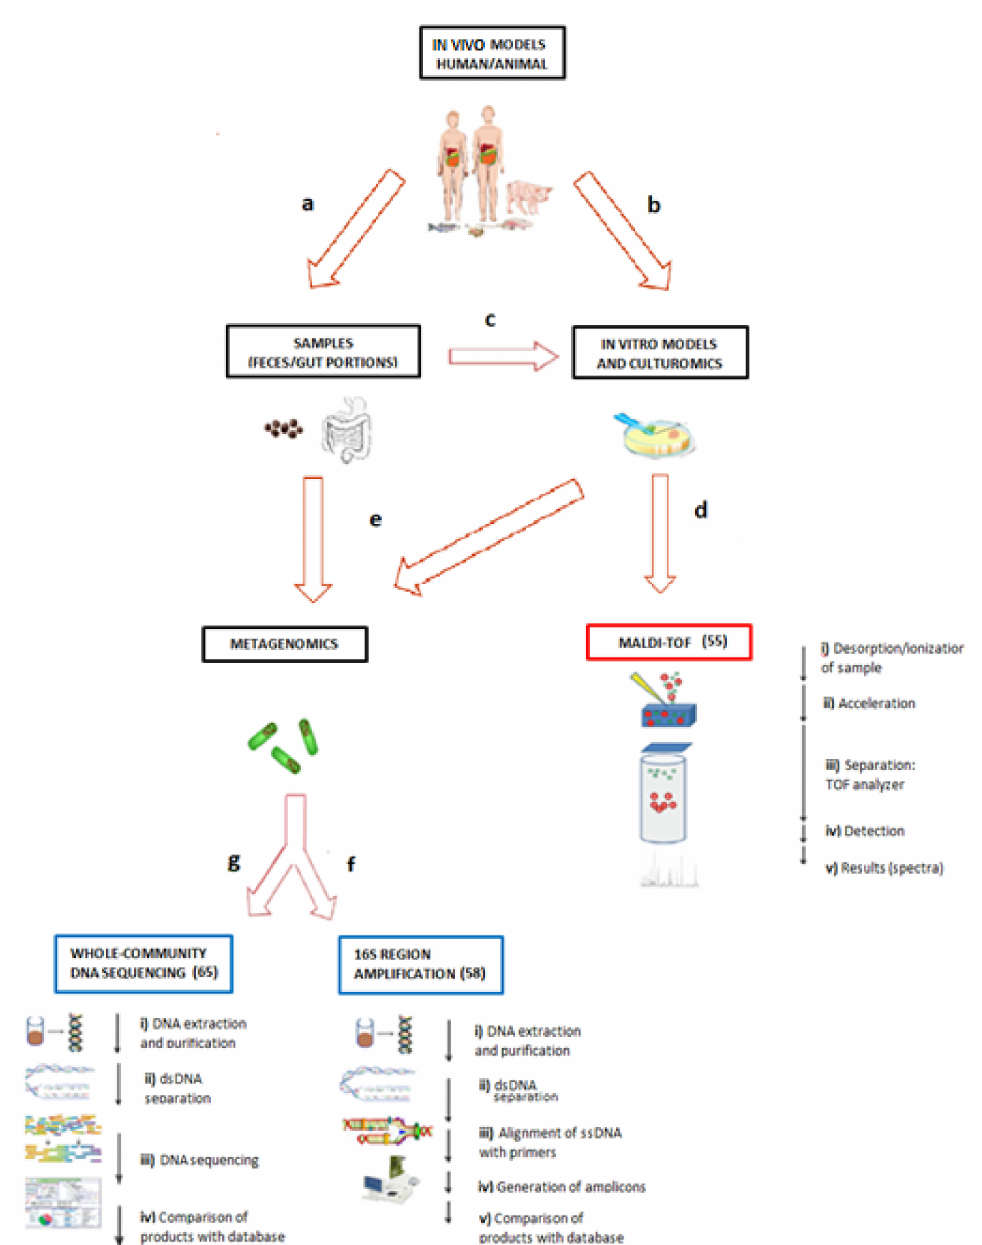
Figure 1. Primary possibilities for microbiota research. To understand the roles and interactions of the microbiota, we can start from the animal sources for ( a ) the development of an in vivo model and to obtain samples such as feces or microbiota from the gut, and ( b ) to obtain gut regions and to develop in vitro continuous organ cultures that mimic the biological environment. Likewise, once the samples from the animal models are obtained, ( c ) culturomics can be used as a powerful approach to identify the uncultured members of the gut, search for differences between species at more than the phylum level, and generate results more quickly by coupling tools such as ( d ) matrix-assisted laser desorption/ionization–time of flight (MALDI–TOF) to generate valid and reproducible results. On the other hand, for both the culture and samples, the researcher can use ( e ) the metagenomics approach, which can be divided into two main techniques: ( f ) The 16S ribosomal sequence amplification, which provides information related to phyla and the abundance in the sample, or ( g ) whole microbial DNA sequencing, which provides more information than simply the phylum or abundance, showing the relationship between microbial enzymes, metabolic pathways, or genetic expression, and diseases such as obesity and others. This figure was made using Creative Commons resources and cannot be copyrighted by